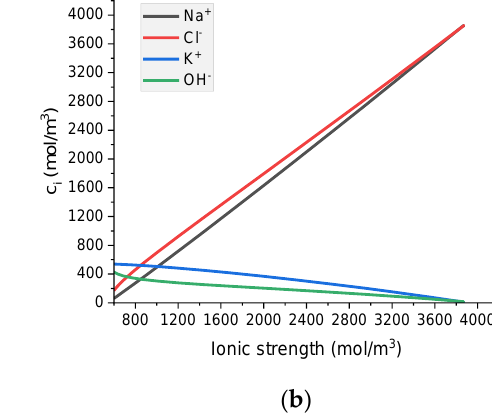
Figure A1. Calculated ( a ) densities of Na-K-Cl-OH water solutions using the Allakhverdov and Zhdanovich [58] and Hörsak and Slama [72] models as a function of ionic strength; and ( b ) corre- sponding ion concentrations as a function of ionic strength.